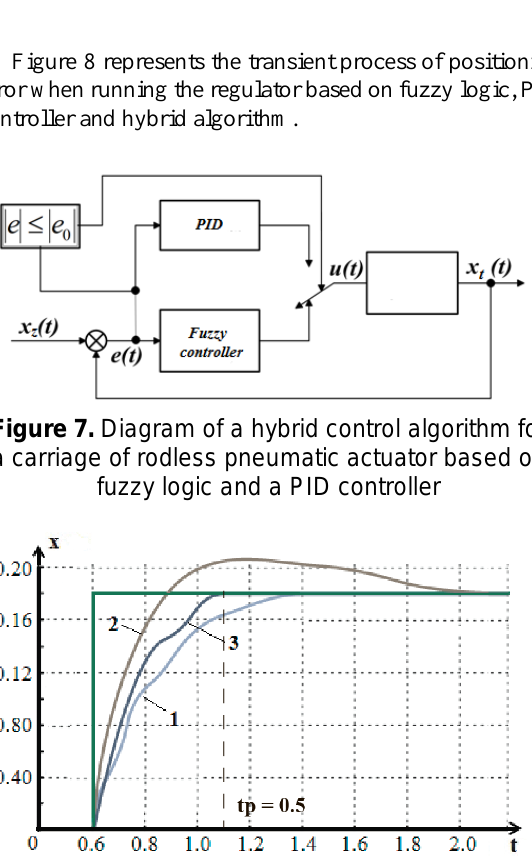
Figure 8. The transient process of positioning er- ror when the regulator is operated on the basis of fuzzy logic (1), PID controller (2), and hybrid algo- rithm